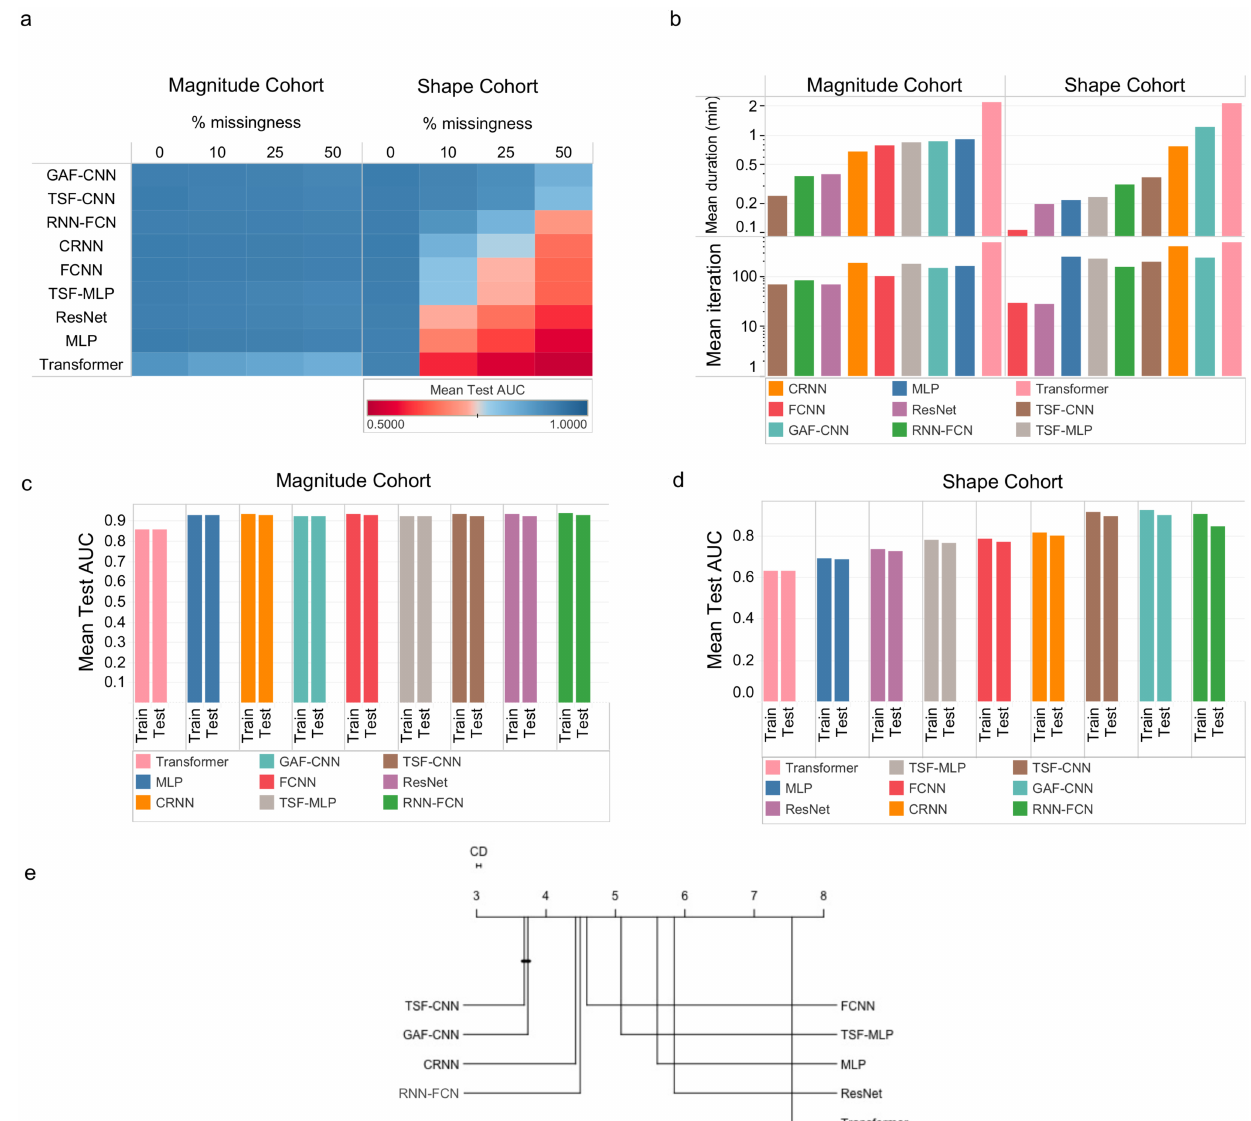
Fig. 3 Model performance on simulated data by over fi tting and training time. a Area under the receiver operating characteristic curve (AUC) differences of train and test sets over different levels of missingness. b Training durations and iterations. c Model over fi tting was evaluated by comparing the AUC differences for each deep learning method in the training sets and the test sets based on ( c ) changes in trajectory magnitude and ( d ) changes in trajectory shape. e Critical difference plot to compare model ’ s performance based on their test AUC (Lower CD value is are depicted in Supplementary Fig. 11. In the magnitude simulation cohorts, AUCs of models, except Transformer were ≥ 0.94 when class overlapping is <90%. Transformer had AUCs of >0.88 for the same condition. AUCs decreased from 0.95 to 0.86 (0.82 for Transformer) for magnitude cohorts that overlapped between 90 and 100%. For the shape cohorts, AUCs of models ranged from 0.85 to 1 for 100 – 0% distribution overlap. All models had AUCs of >0.99 for overlaps of <40%, and AUC of >0.94 for overlaps of <90%. Data missingness . We investigated the impacts of data missing- ness on model prediction accuracies based on missingness of 0, 10, 25, and 50%. In the magnitude simulation cohort, all models, with the exception of Transformer that had AUCs from 0.84 to